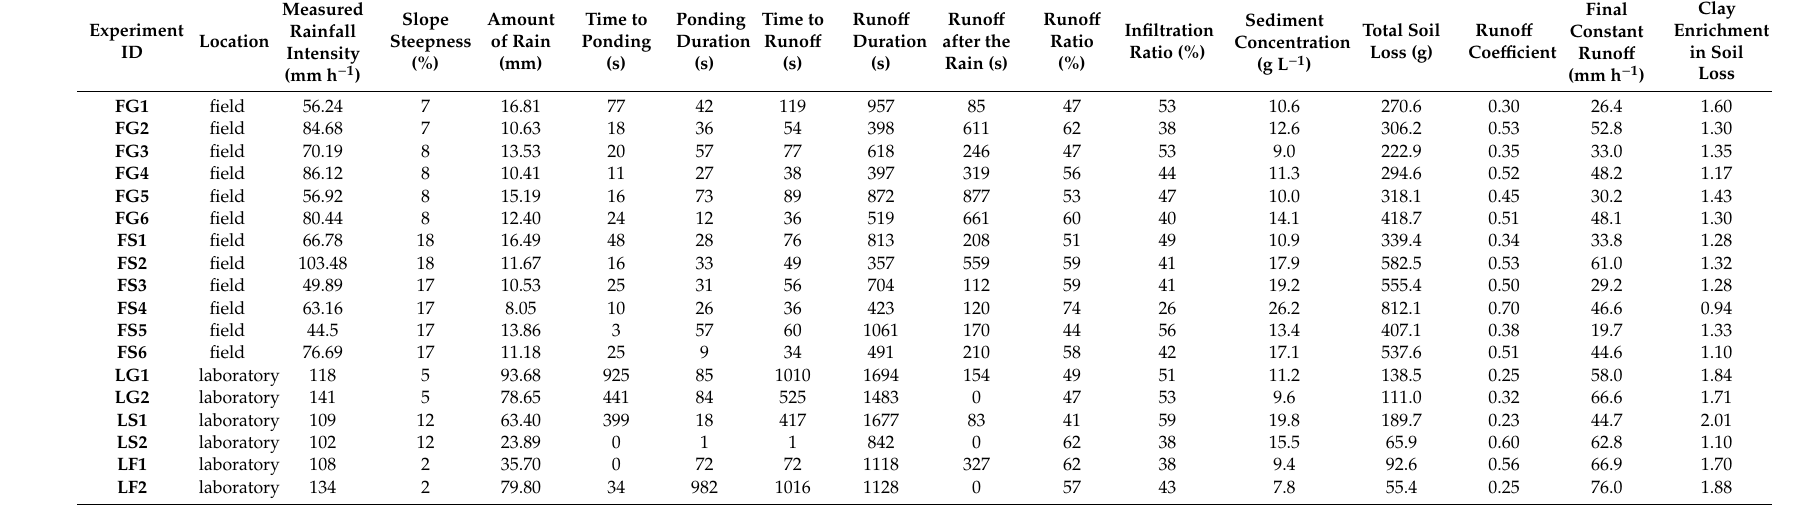
Table A3. Main properties and calculated parameters of the